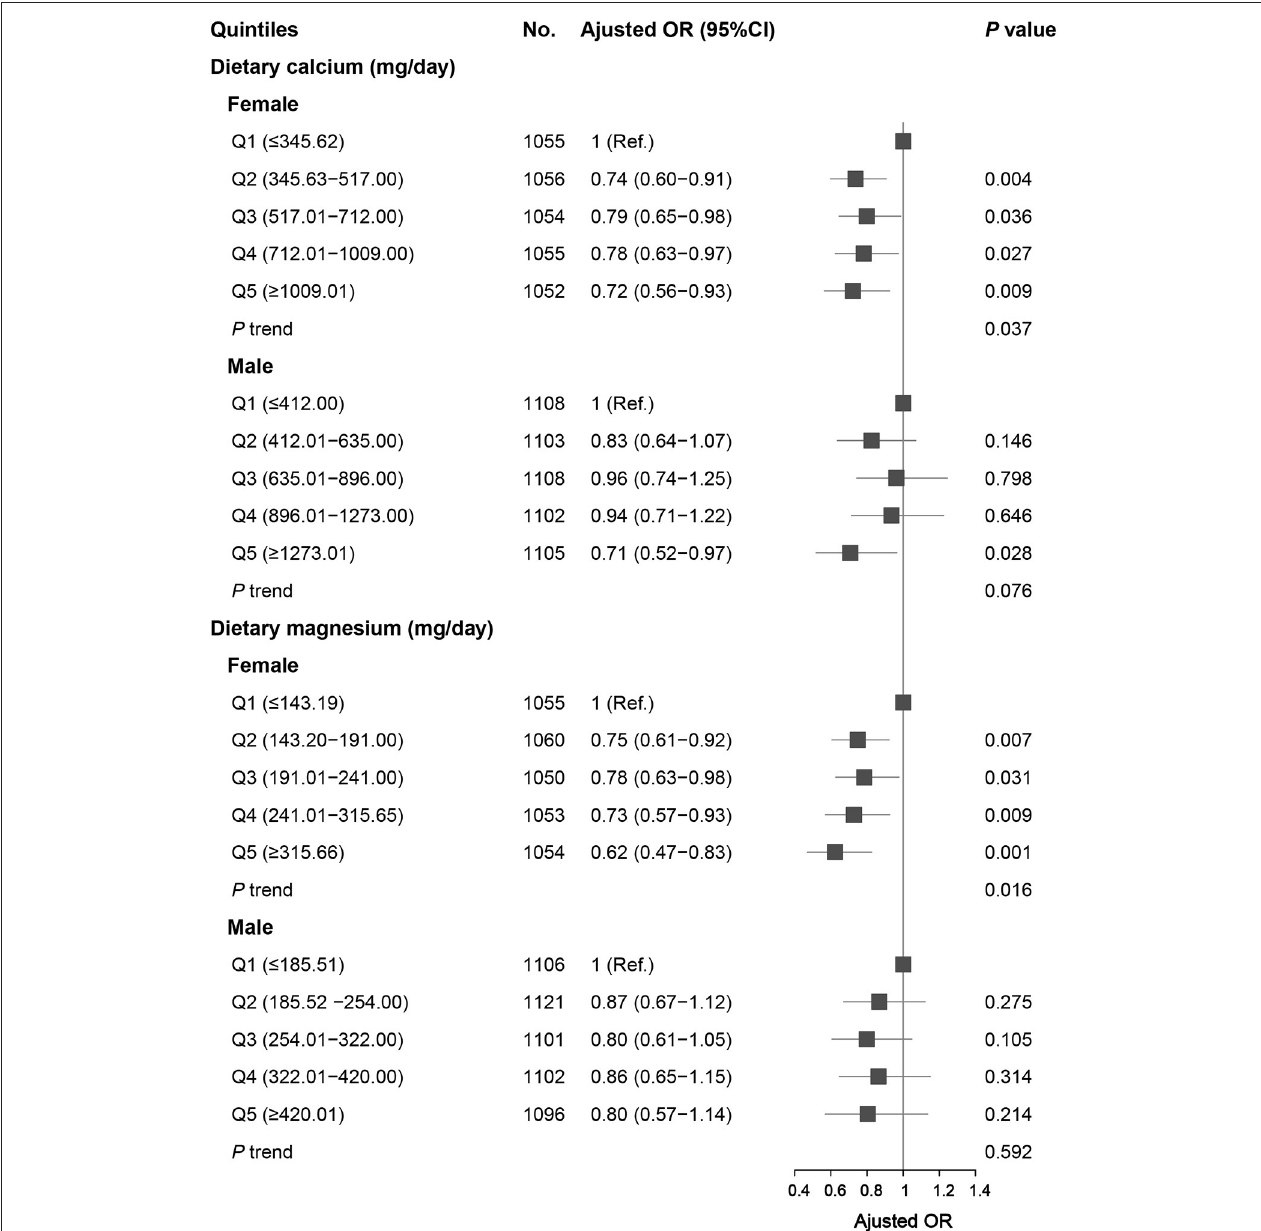
FIGURE 1 | Association between dietary calcium and magnesium intake and headache in different sex groups. Data were presented as OR (95% CI). Limit lines indicate 95% CI. ORs were adjusted for age, race/ethnicity, smoking, drinking, marital, education level, BMI, energy intake, protein intake, carbohydrate intake, calcium supplement, magnesium supplement, vitamin D supplement, hypertension, diabetes, stroke, coronary heart disease, C reactive protein, and total cholesterol.